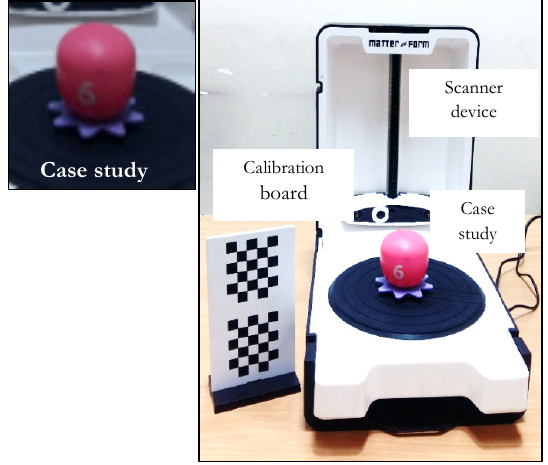
Fig. 5. Dome Case Study.